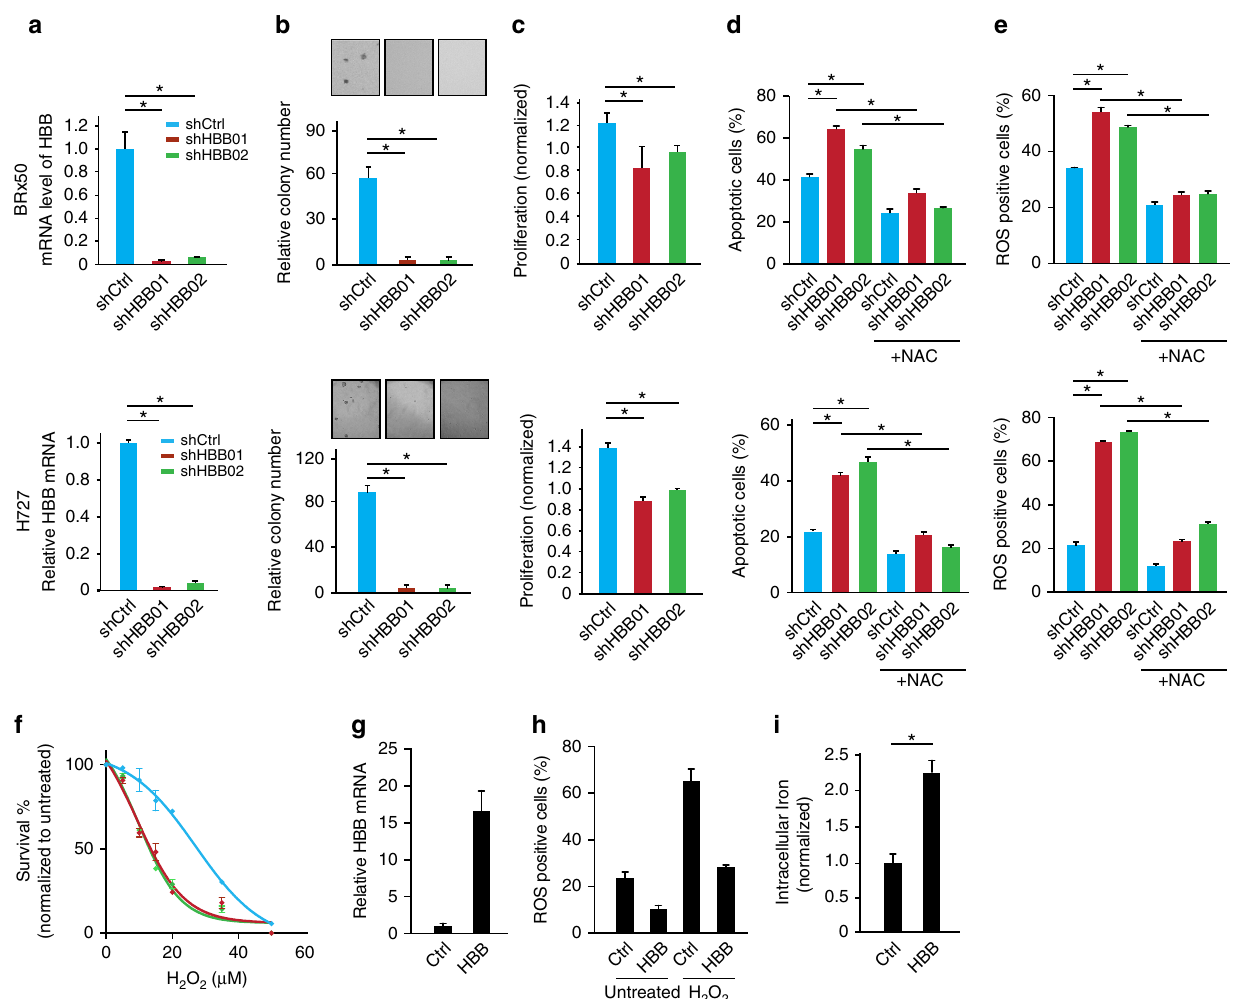
Figure 3 | HBB contributes to the survival of tumour cells under ROS stress. ( a – e ) top panel: BRx50 cells; bottom panel: H727 cells ( a ) Bar graph showing effective shRNA-mediated knockdown of HBB. ( b ) Bar graph showing that HBB depletion impairs colony formation in soft agar (measured at 3 weeks). Representative images are shown. ( c ) Bar graph showing that depletion of HBB reduces short-term proliferation of BRx50 cells (5 days) and H727 cells (24h) cultured in suspension. ( d , e ) Bar graph showing that HBB depletion increases apoptosis and intracellular ROS levels in cells cultured in suspension for 24h; pre-treatment of cells with the anti-oxidant NAC, rescues both ROS levels and apoptosis. ( f ) Bar graph showing that HBB- depleted H727 cells exhibit increased sensitivity to H 2 O 2 compared with control cells. ( g ) Real-time PCR showing the relative HBB mRNA levels in BRx50 cells at baseline (Ctrl) or following stable expression of ectopic HBB . ( h ) Bar graph showing that ectopic overexpression of HBB in BRx50 cells reduces intracellular ROS under basal conditions and following treatment with hydrogen peroxide. ( i ) Bar graph showing that overexpression of HBB increases total iron within BRx50 cells compared with control cells. All data ( a – i ) are represented as mean ± s.d. n ¼ 3; *denotes a statistical significance at P o 0.05 ( t